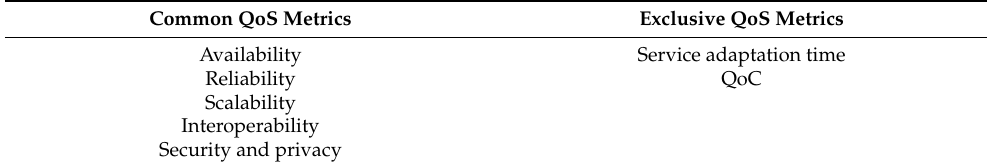
Table 3. Common QoS metrics between IoT platforms and the CMPs and exclusive QoS metrics in the CMPs related to their processing